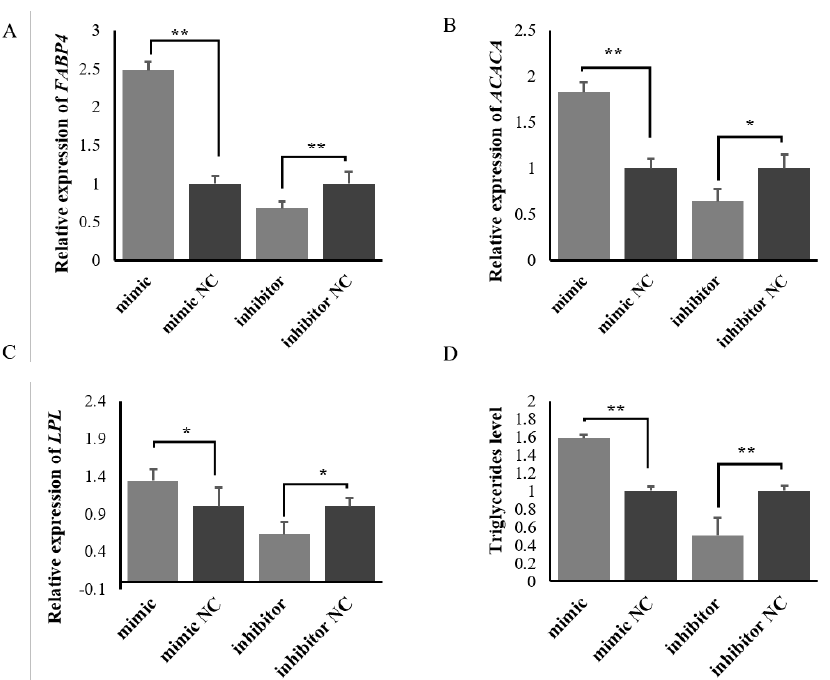
Figure 6. The effect of miR-200c on FABP4 ( A ), ACACA ( B ) and LPL ( C ) and triglycerides level ( D ) in ovine MECs when the miR-200c mimic, the miR-200c inhibitor and their NC were transfected into ovine MECs. Data are presented as mean ± SD ( n = 3). ** p < 0.01 and * p < 0.05.